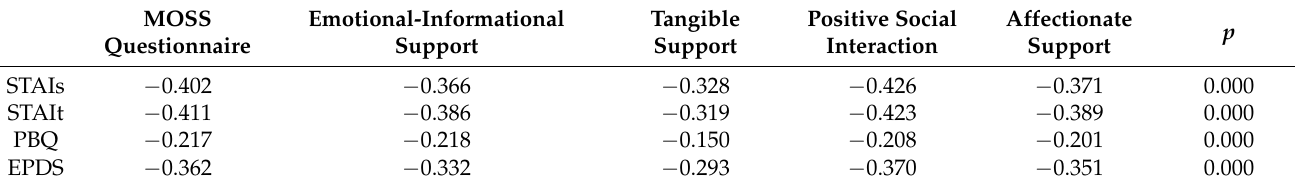
Table 4. Correlation between the MO-SSS score and EPDS, STAIs, STAIt and PBQ scores (r = Pearson). MOSS